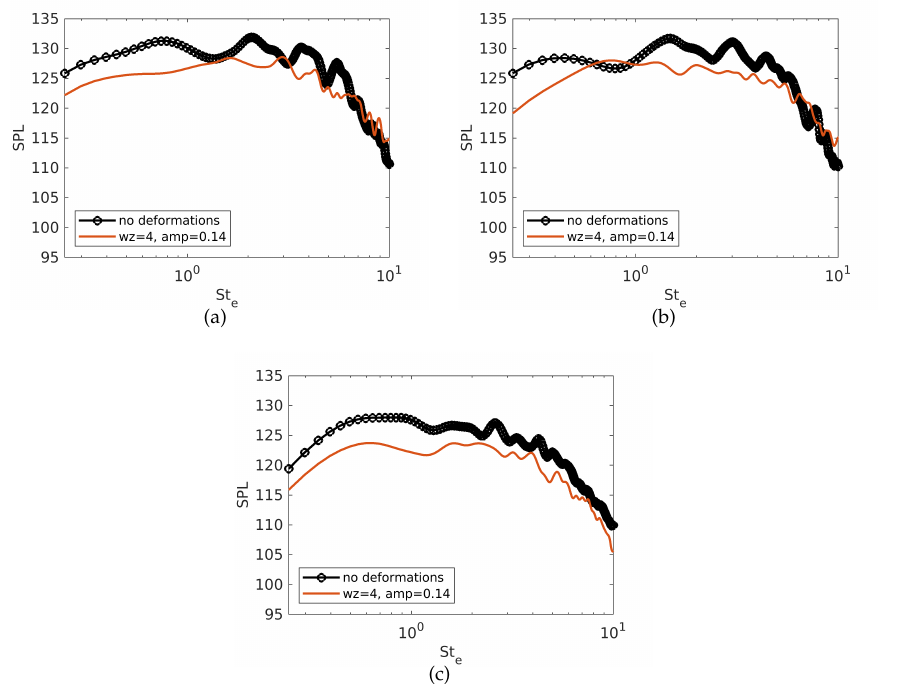
Figure 11. Typical acoustic spectra that show a reduction: ( a ) Probe 1; ( b ) Probe 2; ( c ) Probe 3. The overall sound pressure levels (OASPL) observed at the probe points are plotted in Figures 12 and 13. In Figure 12, the OASPL’s are plotted for the five configurations that do not involve trailing edge deformations. For the probes that are located above the jet, there is a significant increase in the radiated noise for the case corresponding to the smallest distance from the nozzle center ( d = 0.65 D j , L = 5 D j ). This is to be expected for this case since the end of the potential core is the closest to the trailing edge of the plate. For the probe located under the jet, there is an increase in the radiated noise for the case corresponding to the shortest plate length. This is an indication of a reduced shielding